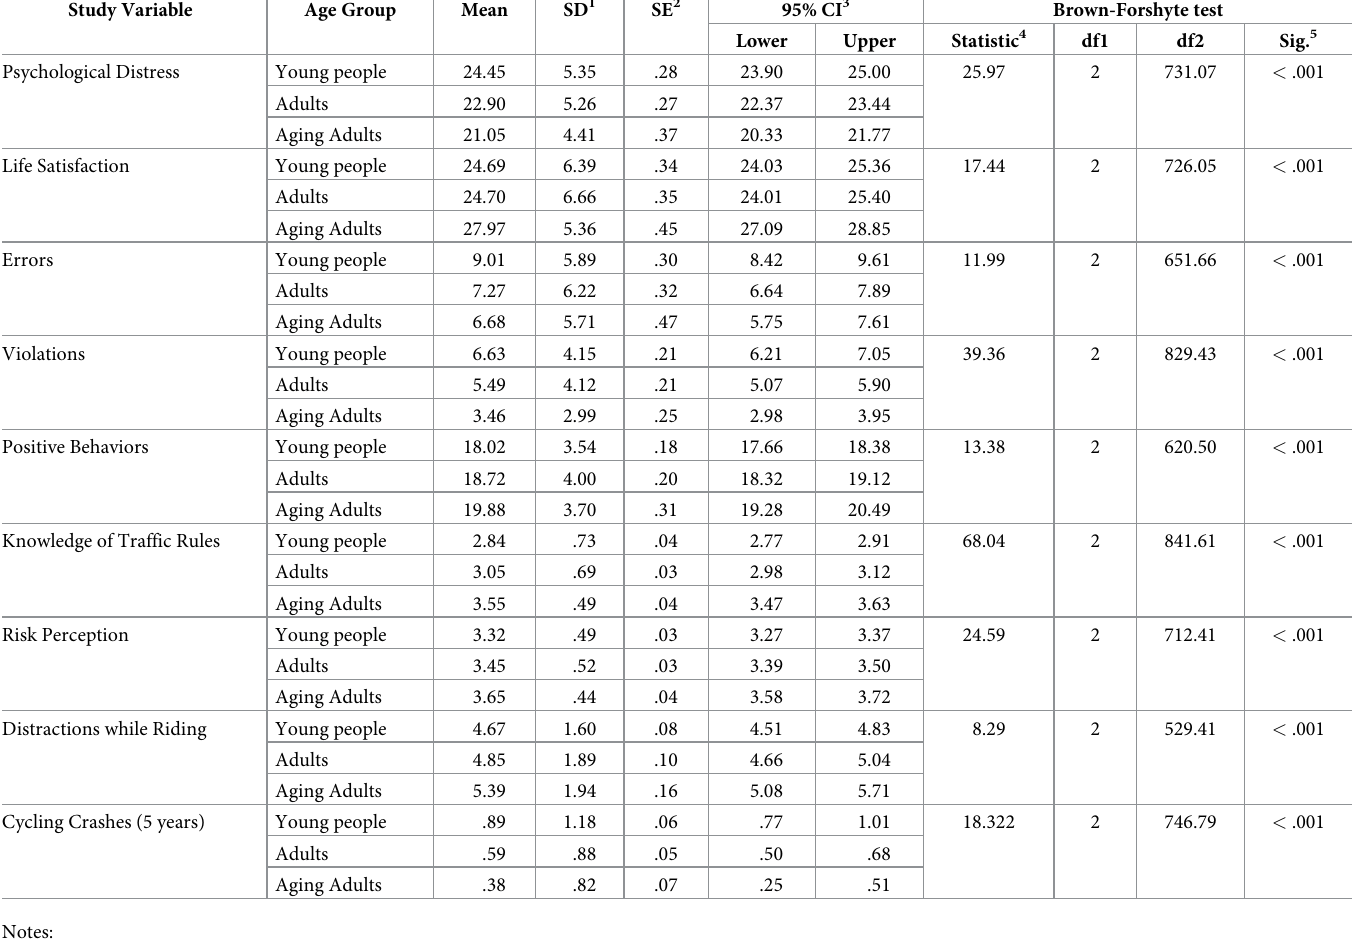
Table 3. Descriptive data for study variables and age-based robust mean